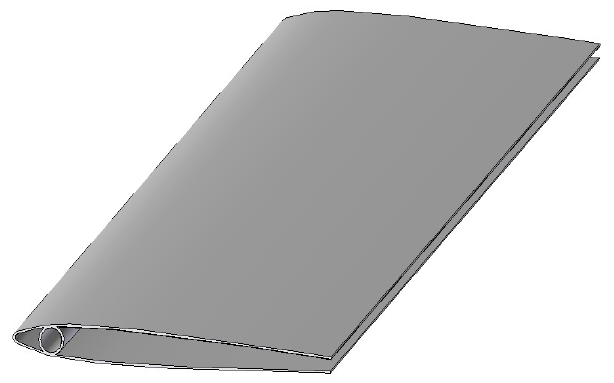
Figure 8. The wing-testing model with its rotation axis (the gap between the upper and lower wing cambers is exaggerated and not to scale).